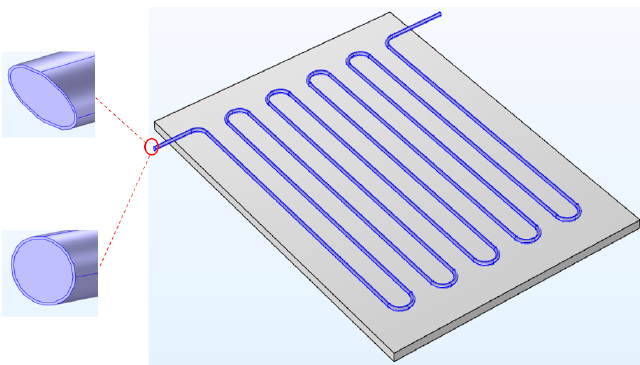
Figure 4. 3D view of the proposed flat plate serpentine designs.